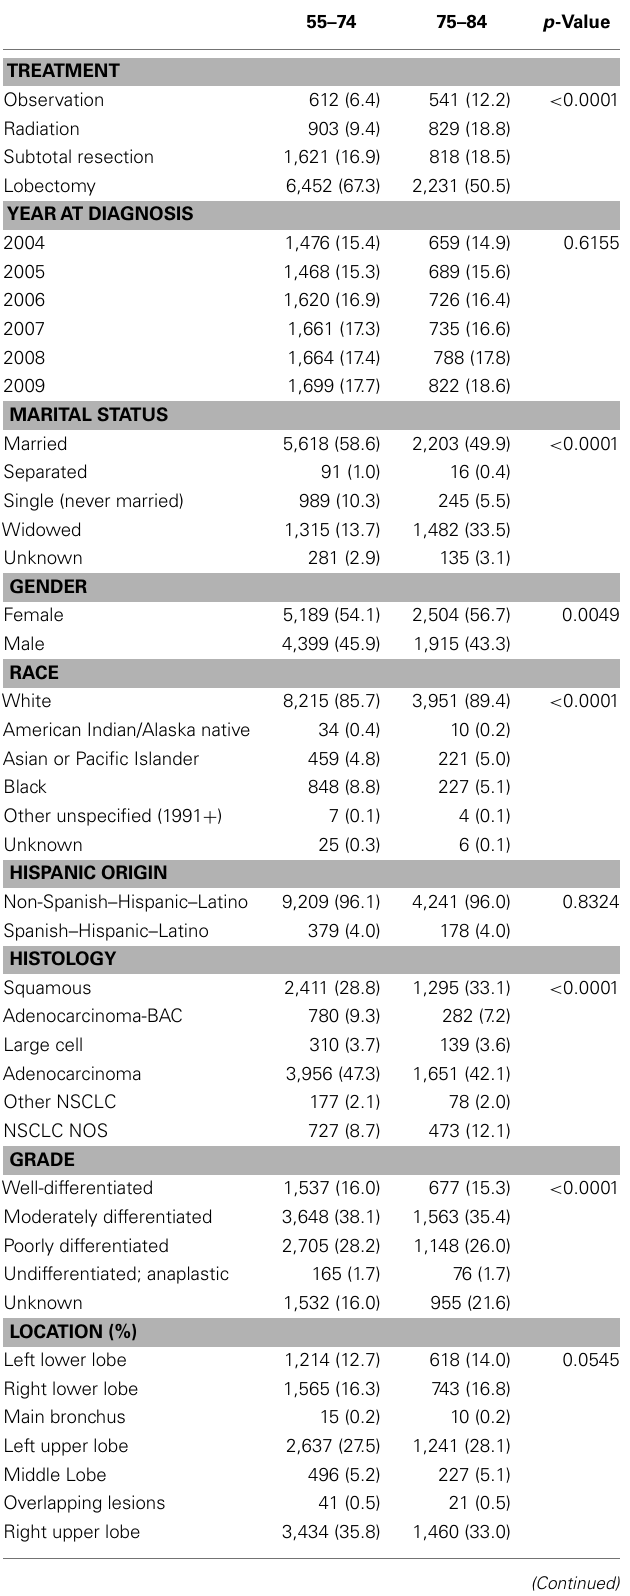
Table 1 | Patient characteristics by age groups ( N = 14,007)